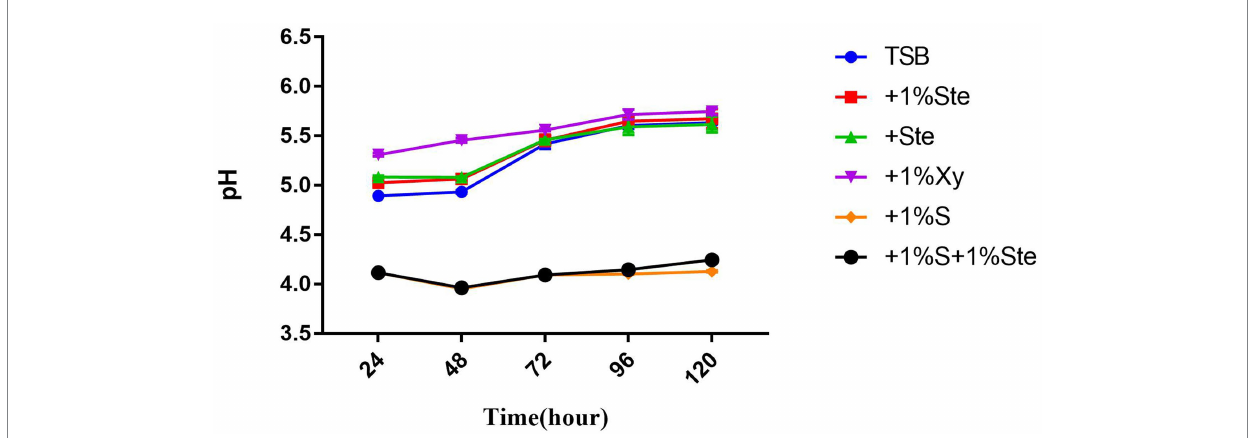
FIGURE 6 Effects of stevioside on acid production. pH value shows acid production at different times. pH measurement of different groups at 24, 48, 72, 96, and 120 h in various media. The data represent the means ±